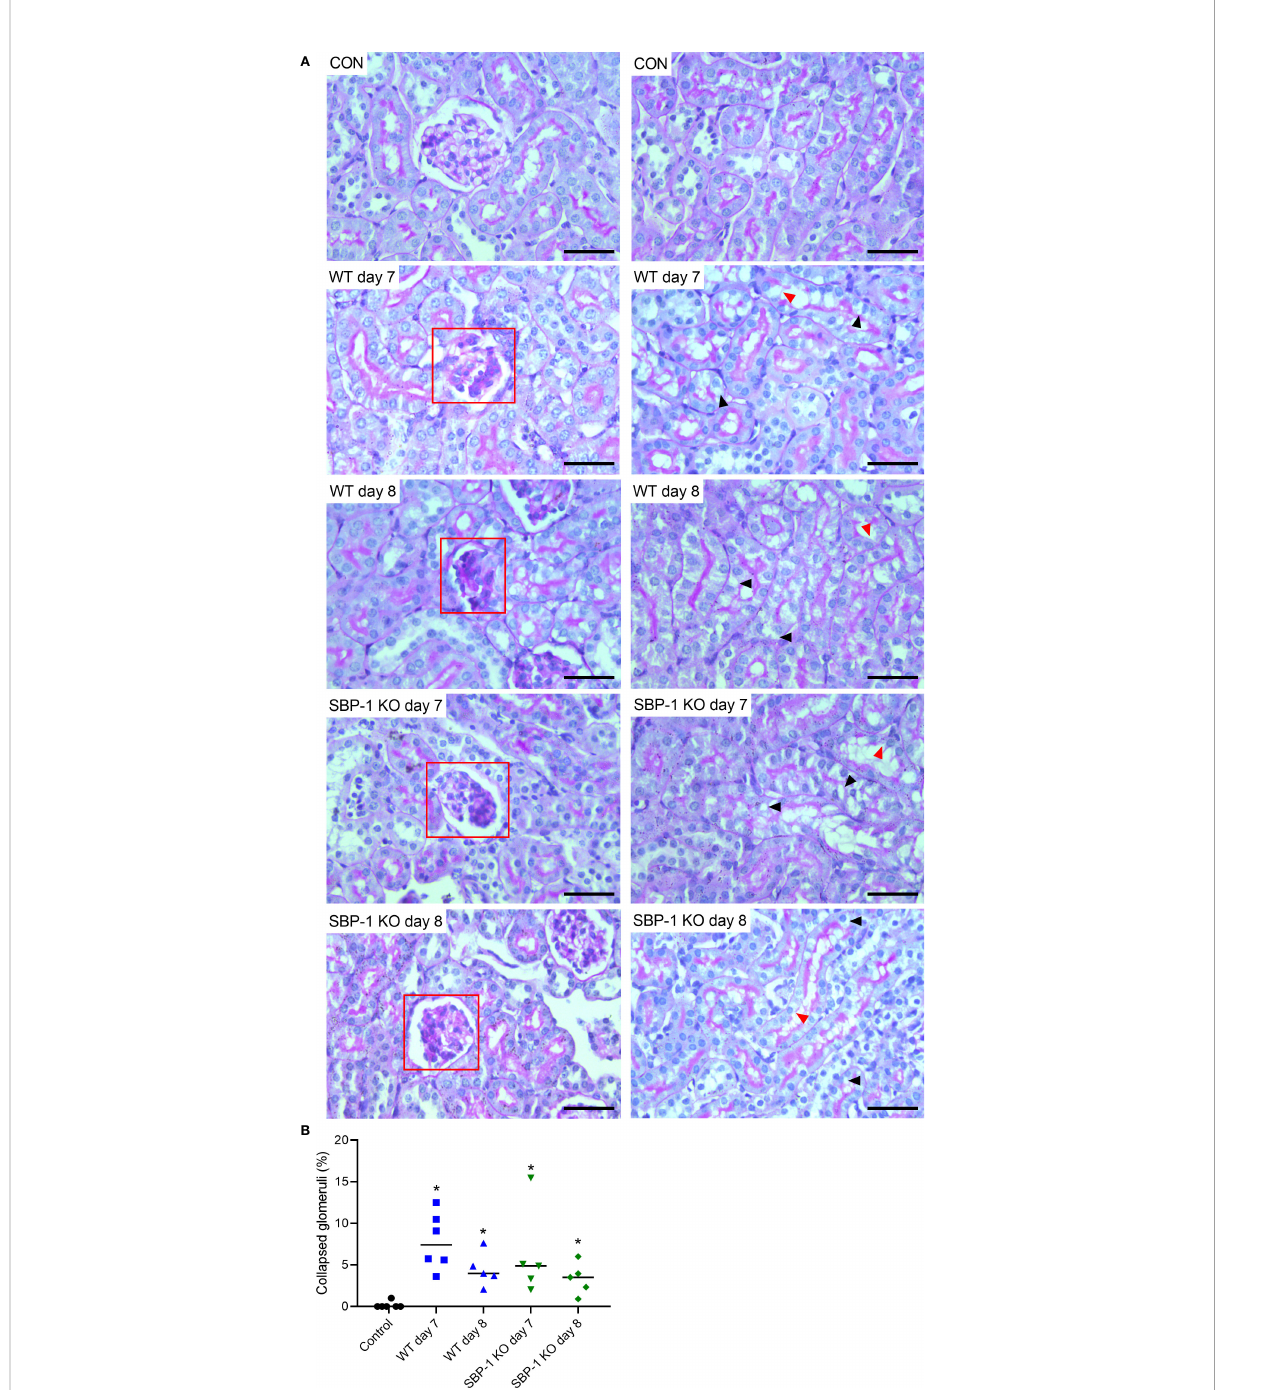
FIGURE 6 Similar tubular injury and collapse of glomerular capillary tuft in kidneys of WT and SBP-1 KO infected mice. C57BL/6 mice were infected with WT and SBP-1 KO Pb NK65 parasites and at day 7 and 8 p.i. kidneys were dissected. (A) Sections were stained with PAS. Representative images are shown (original magni fi cation x40, bar = 50 µm). Red frames indicate collapse of glomerular tufts. Black arrowheads indicate vacuolization of proximal tubular epithelial cells, red arrowheads indicate loss of brush border of proximal tubular epithelial cells. (B) Percentage of glomeruli with collapsed glomerular tufts counted on PAS stained kidney sections Asterisks above data points indicate signi fi cant differences compared to control mice, *p < 0.05. Data of two experiments, Control: n = 6, WT d7-d8: n = 5-6, SBP-1 KO d7-d8: n = 5. Mann-Whitney U test with Holm- Bonferroni correction for multiple testing (number of tests = 6) was performed in panel